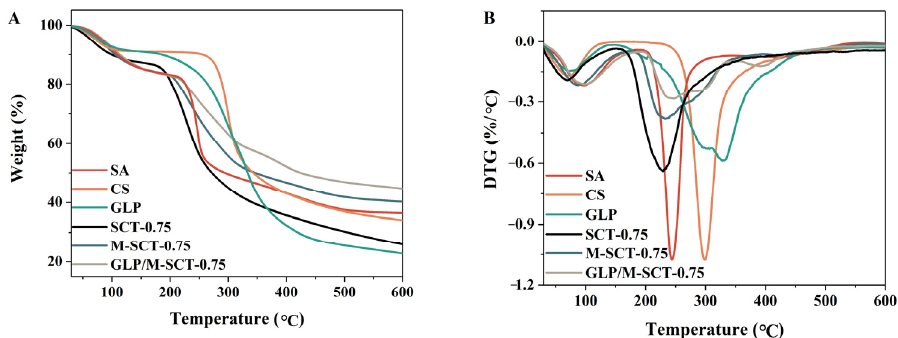
Figure 7. Polymers of polysaccharides and peptides can improve the stability of peptides during thermal denaturation. TGA ( A ) and DTG ( B ) thermograms of the SA, CS, GLP, SCT-0.75 hydrogels, M-SCT-0.75 hydrogels, and GLP/ M-SCT-0.75 hydrogels were measured by TGA measurements.